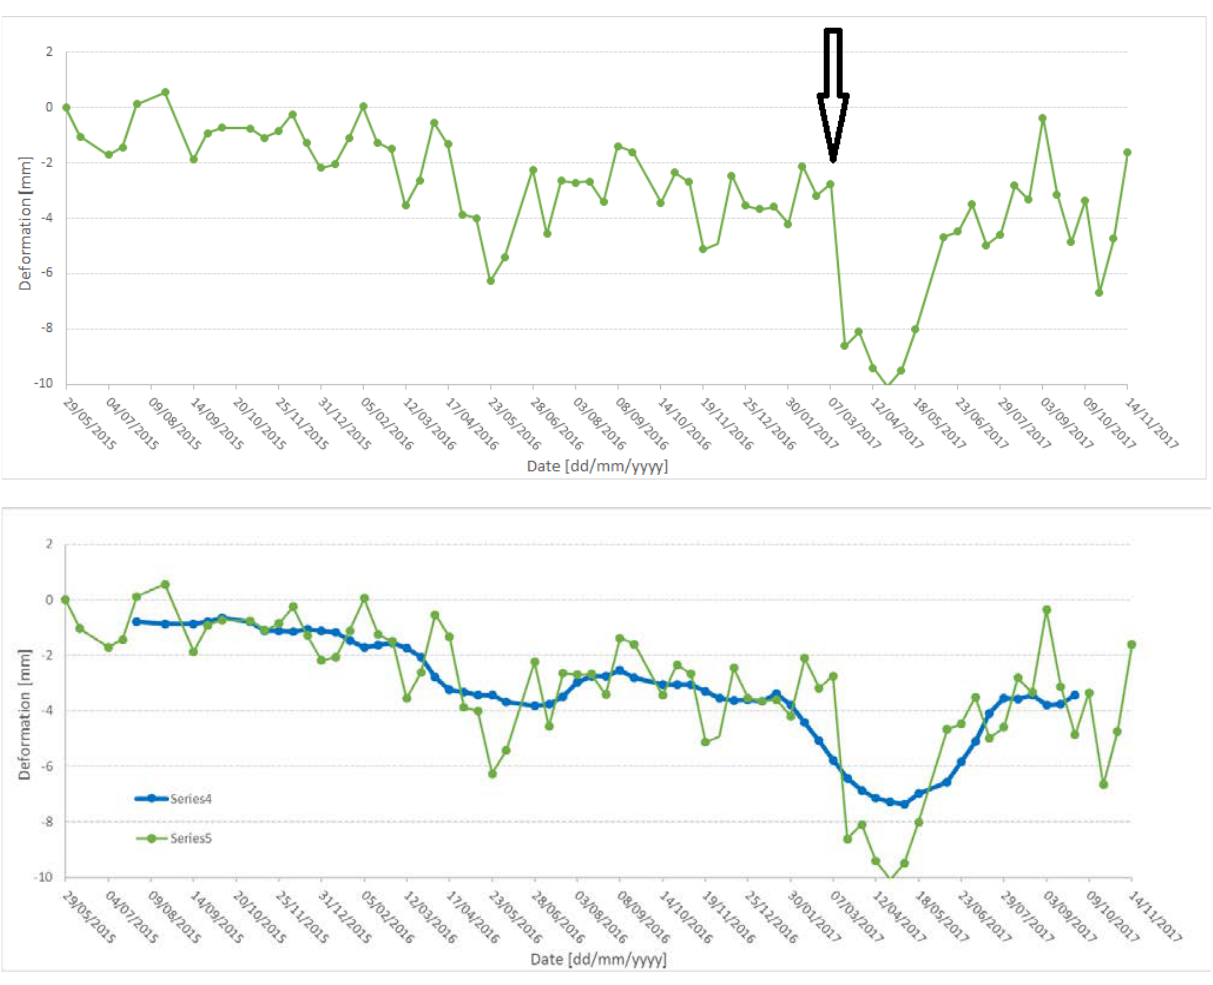
Figure 2. Example of deformation time series that correspond to a sudden deformation, which is then followed by a deformation recovery (above). Low-pass version of the same deformation time series, in blue (below)